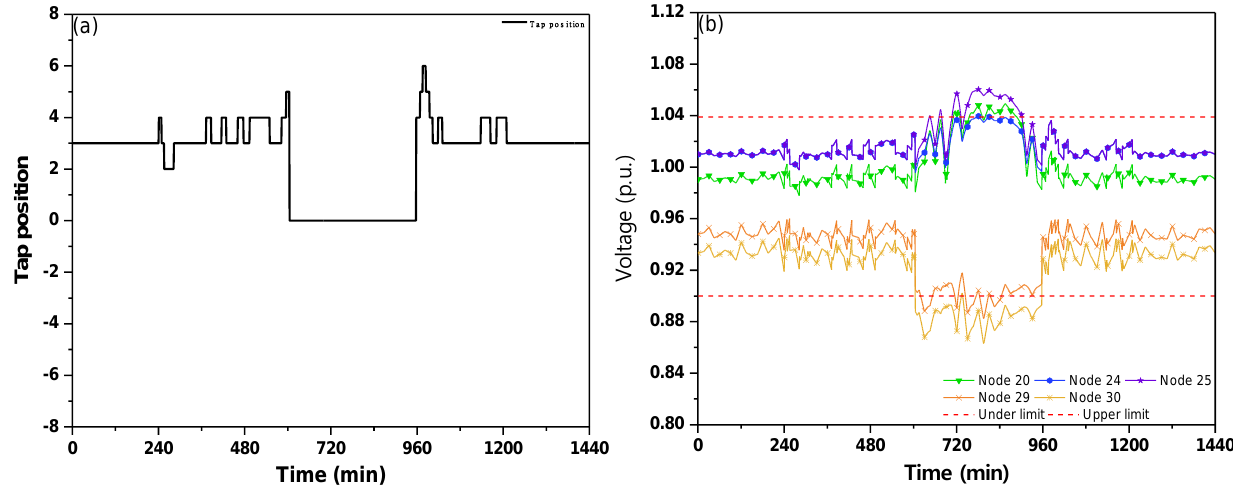
Figure 9 shows the simulation results of Case 2. Unlike Case 1, the reference voltage is reset based on the direction of the power flow, but the reference point is fixed in the middle node of Feeder 5. The tap position on the forward power flow was set lower than that of Case 1 because the voltage drop in Feeder 5 occurs only with the line impedance. As a result, Feeders 1, 2, and 6 connected to heavy loads generated low-voltages. In addition, in the reverse power flow situation, as the reference voltage increases, the tap position increases in some periods; but as the PV output increases, the tap position decreases to suppress the voltage increase. Owing to this, it is possible to prevent the over-voltage of the PV-connected line; however, the low-voltage of Feeder 6 is larger.